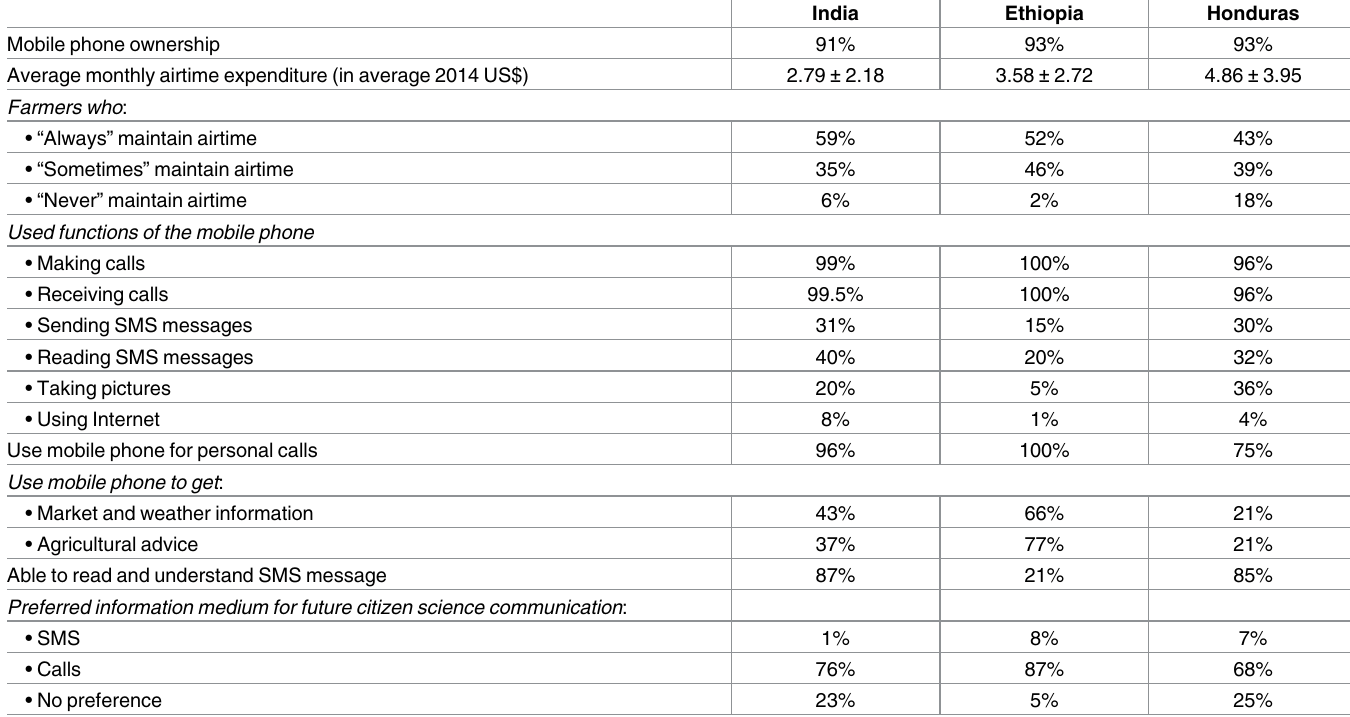
Table 6. An overview of mobile phone usage variables in the three